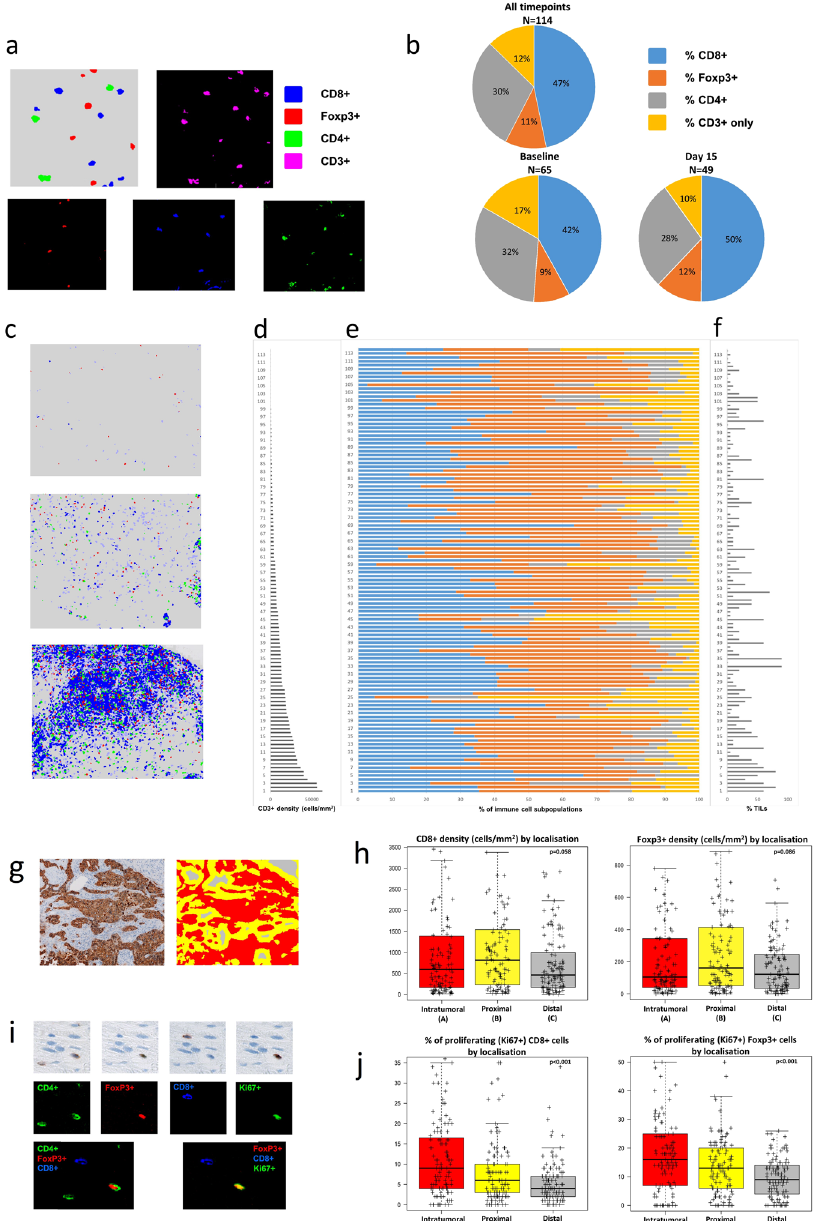
Fig. 2 Multiplexed spatial cellular phenotyping of breast cancer. a Representative example of the analytical pipeline classifying immune cells (top left) and colour deconvoluted images with red, green and blue colours assigned to Foxp3 + , CD4 + and CD8 + , respectively (bottom) and magenta for CD3 + (top right). Images at 25×. b Proportions of CD3 + immune subsets across all patients ’ samples (up), baseline samples (down to the left) and day 15 samples (down to the right). CD8 + , Foxp3 + , CD4 + and CD3 + -only in blue, orange, gray and yellow. c Representative examples of breast cancers with low (up), medium (middle) and high (down) T-cell densities. Images at 5×. d CD3 + density results across the entire population of HER2 + breast cancers. Samples are ordered from lowest to highest. e Proportions of CD8 + (blue), Foxp3 + (orange), CD4 + (gray) and CD3 + only (yellow) cells for all patients ’ samples. f Stromal tumour-in fi ltrating lymphocytes (TILs) in breast cancer samples with available NGI data. g Representative example of the spatial analysis areas de fi ned by the image analysis algorithm using cytokeratin as tumour mask. Intratumoural ( a , in red), proximal peritumoural stroma within 30 µm ( b , in yellow) and distal peritumoural stroma >30 µm from the tumour ( c , in gray) regions are shown. Images at 5×. h Boxplots of immune cells densities (CD8 + and Foxp3 + ) according to spatial location. Boxplot legend: centre line: median; bounds of box: interquartile range (IQR); whiskers: highest and lowest value excluding outliers (Q3 + 1.5*IQR to Q1 − 1.5*IQR); markers beyond the whiskers: potential outliers. i Representative example of CD4 + , Foxp3 + , CD8 + and KI67 + sequential immunohistochemistry and co-expression analyses for T cells activity assessment on the same tissue slide (top panel). The colour green, red, blue and green is assigned, respectively, to each individual staining for visualisation purpose, co-expression analyses and virtually multiplexed images ( fi rst image composed by CD4, Foxp3 and CD8 and second image composed by Foxp3, CD8 and Ki67; co- expression in yellow). Images at 50×. j Boxplots of the proportion of proliferating immune cells (CD8 + and Foxp3 + ) according to spatial location. Boxplot legend: centre line: median; bounds of box: interquartile range (IQR); whiskers: highest and lowest value excluding outliers (Q3 + 1.5*IQR to Q1 − 1.5*IQR); markers beyond the whiskers: potential